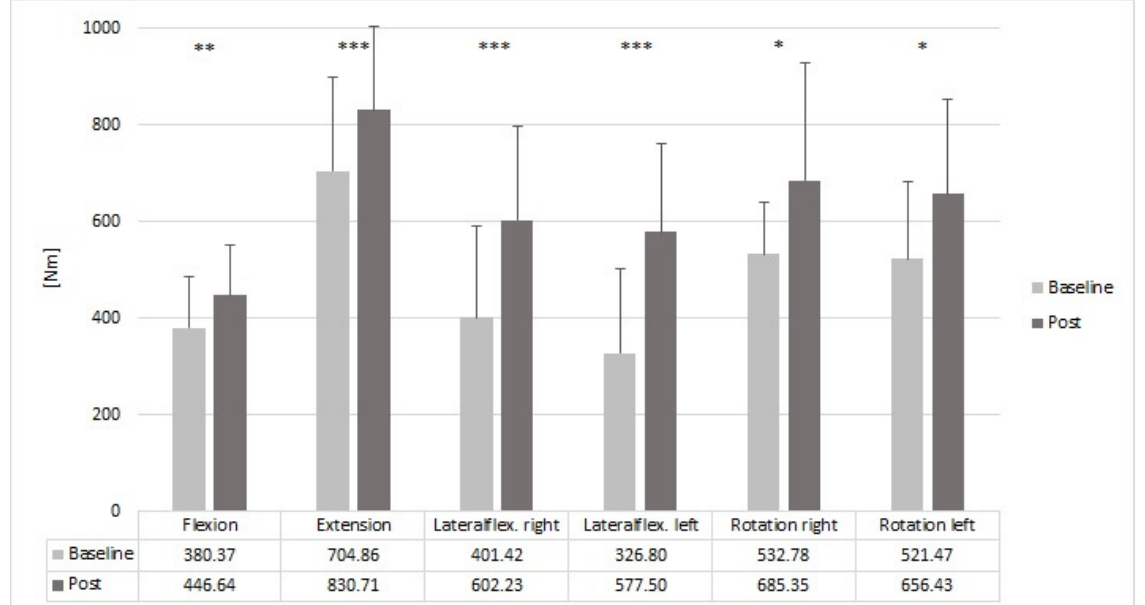
Figure 4. Effects of a 10-week resistance training programme on the MVIC of the trunk. The table shows the mean values of the MVIC at baseline and post-intervention for each outcome. Significant differences are marked with asterisks: * p < 0.05, ** p < 0.01 and *** p < 0.001.